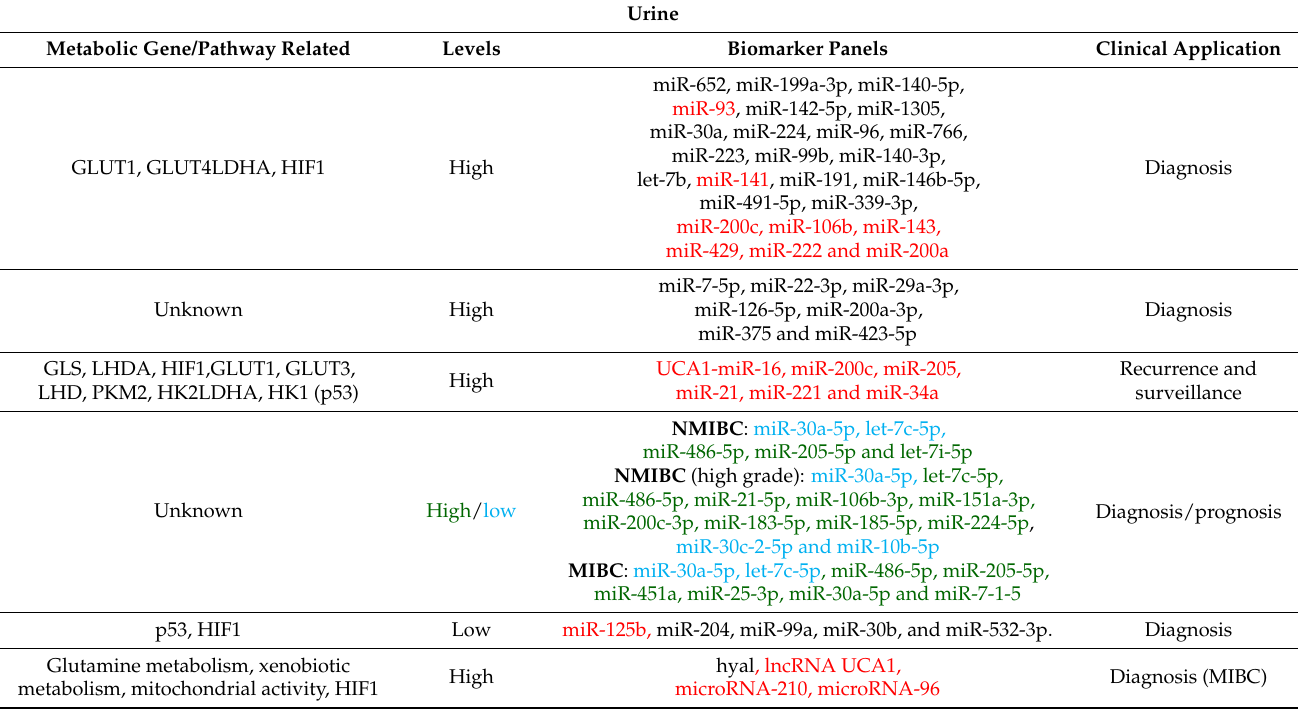
Table 4. ncRNA markers found in urine from patient cohorts with BC.